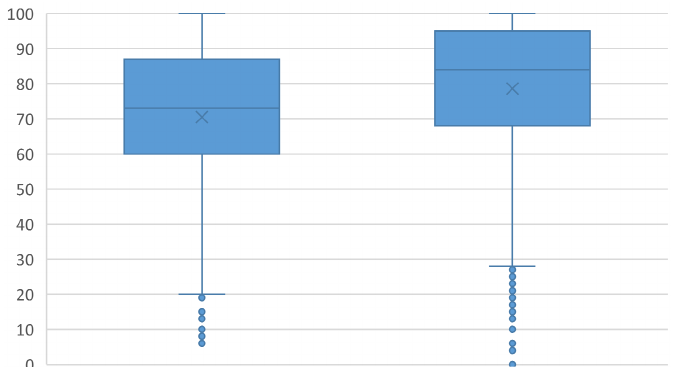
Figure 2. Changes in the percentage of meals prepared in the household before and during the COVID-19 pandemic.